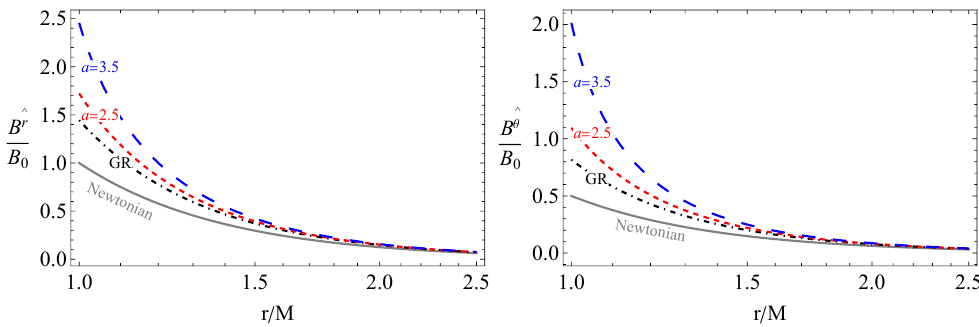
Figure 2. Radial (left panel) and angular (right panel) components of the magnetic field in the polar cap region of an NS with (cid:101) = 0.2 normalized to its value in the Newtonian frame on the surface of the star for different values of the EU